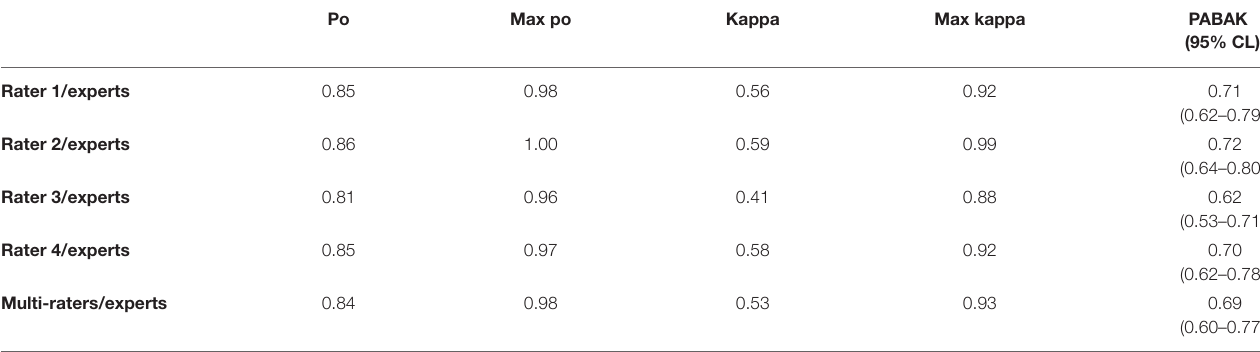
TABLE 2 | Intra-rater agreement for the training level screening criteria for the four non-expert raters. Po Max po Kappa